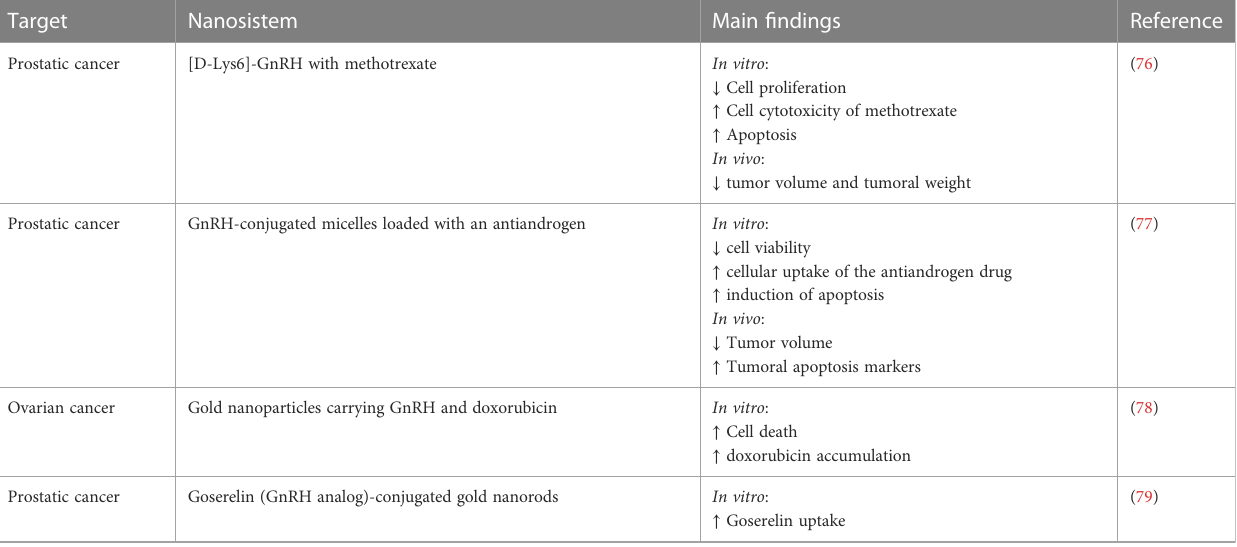
TABLE 1 Summary of different nanosystems that use GnRH analogs to increase the selective delivery of drugs to in vivo and in vitro models of ovarian, prostatic, and breast cancer.